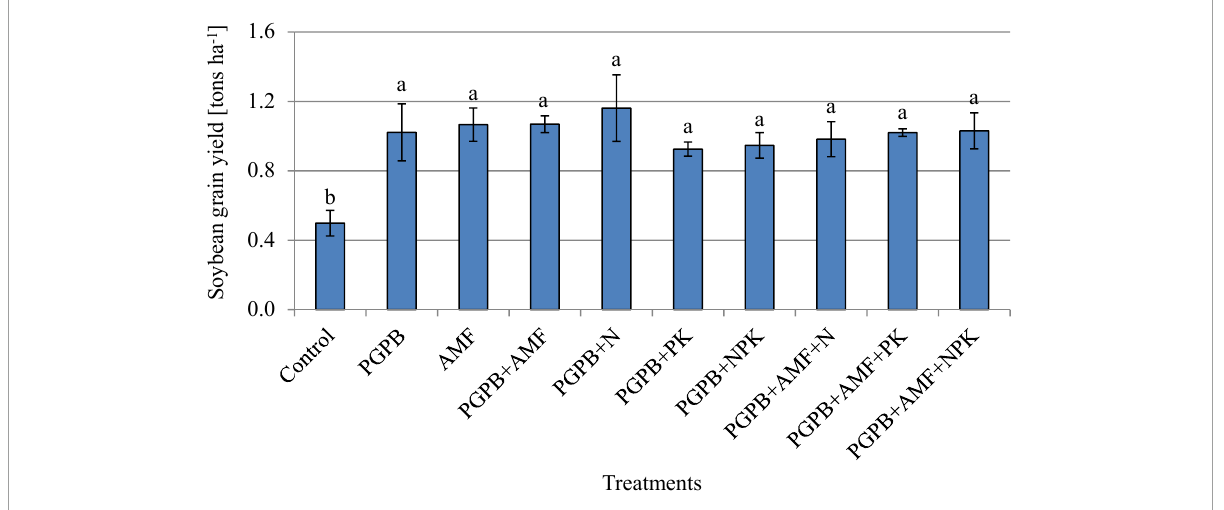
FIGURE6 Soybean grain yield (tons ha 1 ) affected by inoculation of plant growth-promoting bacteria (PGPB) and arbuscular mycorrhiza fungi (AMF), with or without the addition of nitrogen (N), phosphorus (P), and potassium (K) fertilizers. Data (Mean ± SD) with different letters are significantly different (Tukey’s HSD, p < 0.001).